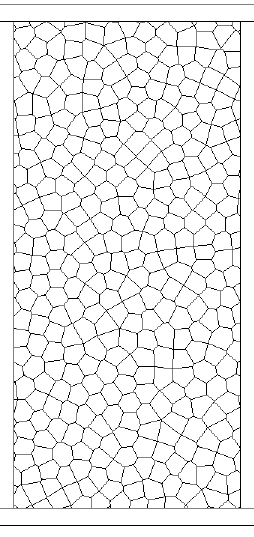
Figure 8. Base model for the compression test.